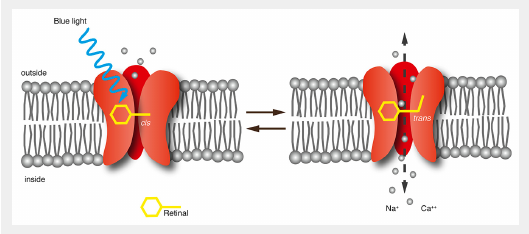
Principle of optogenetics . Channelrhodopsin is an ion channel that binds retinal. With blue light exposure the retinal conformation changes from cis to trans , which gates the ion conductance leading to depolarisation. When expressed in neurons this technique allows the activity to be controlled with high temporal resolution. Additional effectors also inhibit neurons (e.g. light-gated chloride conductance) or control G-protein signalling. (Modified from: Hegemann P, Nagel G. From channelrhodopsins to optogenetics. EMBO Mol Med. 2013;5:173–6. © 2013 EMBO Molecular Medicine, reprinted with permission).